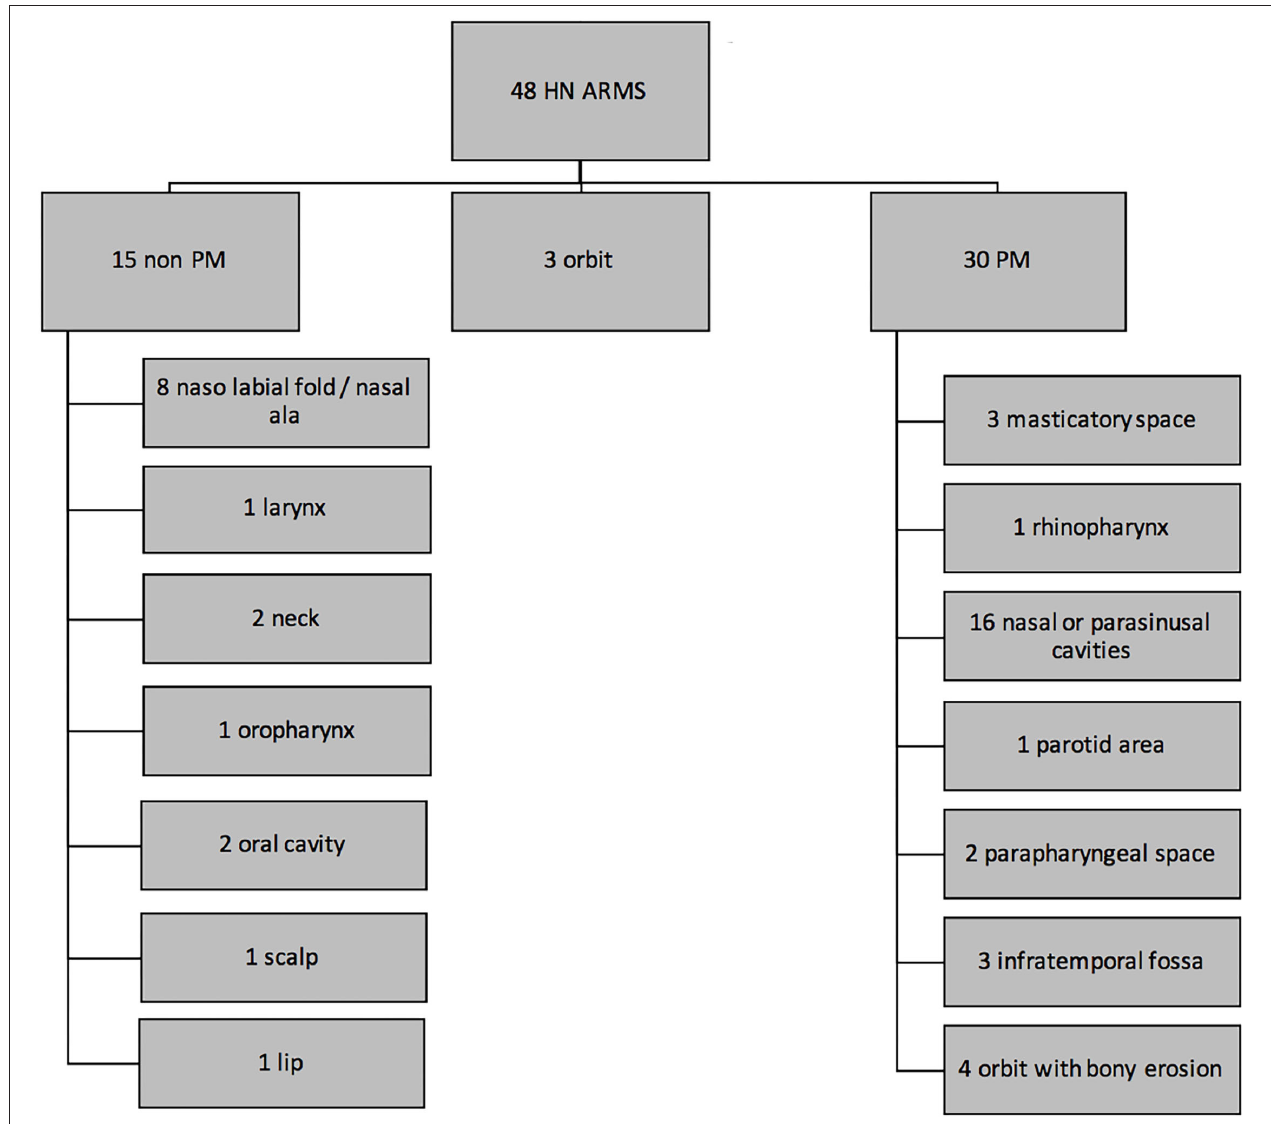
FIGURE 1 | Locations of the 48 head and neck alveolar rhabdomyosarcomas (HN-ARMSs).